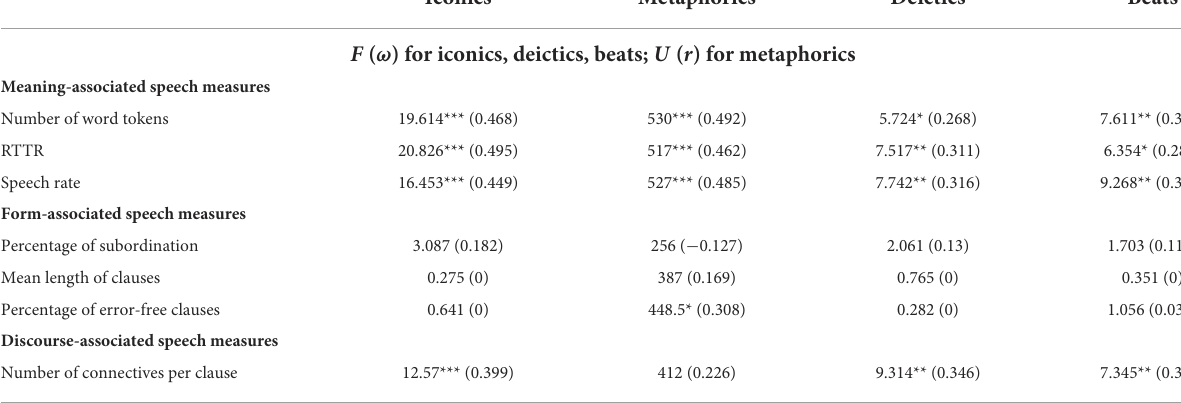
TABLE 9 The contrast of speech measures produced by gesturers and non-gesturers of four types of co-speech